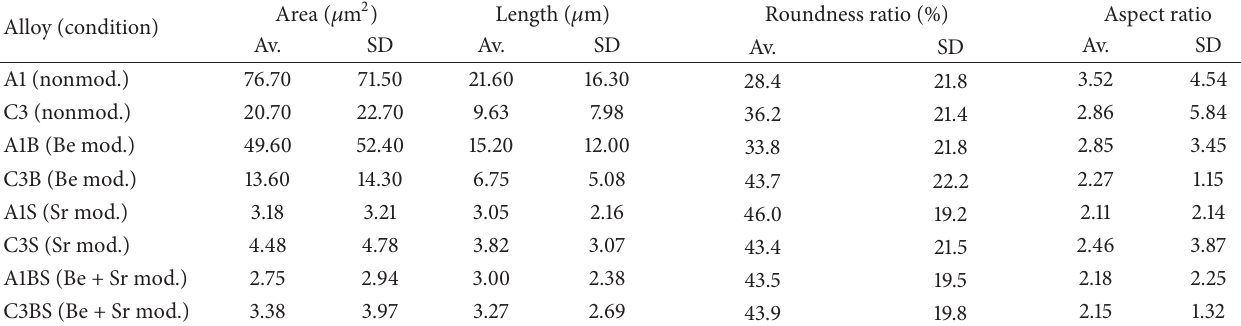
Table 2: Silicon particle measurements for the as-cast 357 alloy samples (obtained from graphite mold castings, DAS 65 𝜇 m). Area ( 𝜇 m 2 ) Length ( 𝜇 m) Roundness ratio (%) Aspect ratio Alloy (condition) Av. SD Av. SD Av. SD Av. SD A1 (nonmod.) 76.70 71.50 21.60 16.30 28.4 21.8 C3 (nonmod.) 20.70 22.70 A1B (Be mod.) 49.60 C3B (Be mod.) 13.60 14.30 A1S (Sr mod.) C3S (Sr